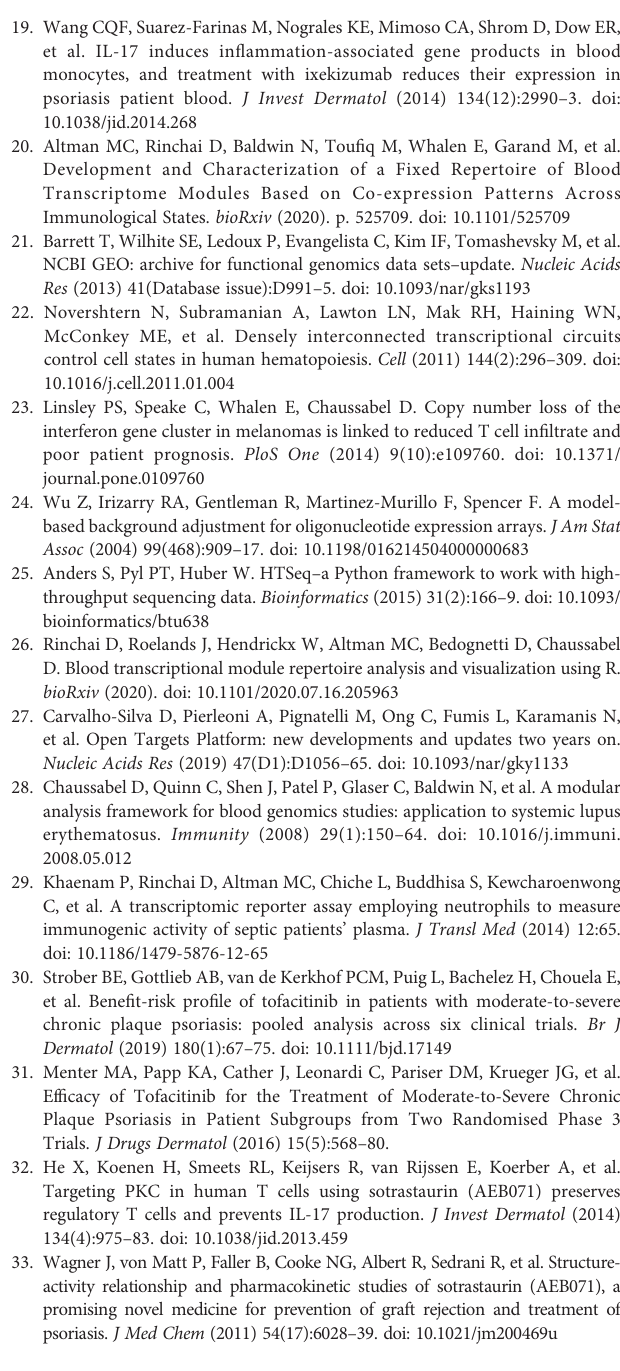
SUPPLEMENTARY FIGURE 1 | Module annotation grid. Complete annotation for the grid used to map the differences in transcript abundance between the cases and